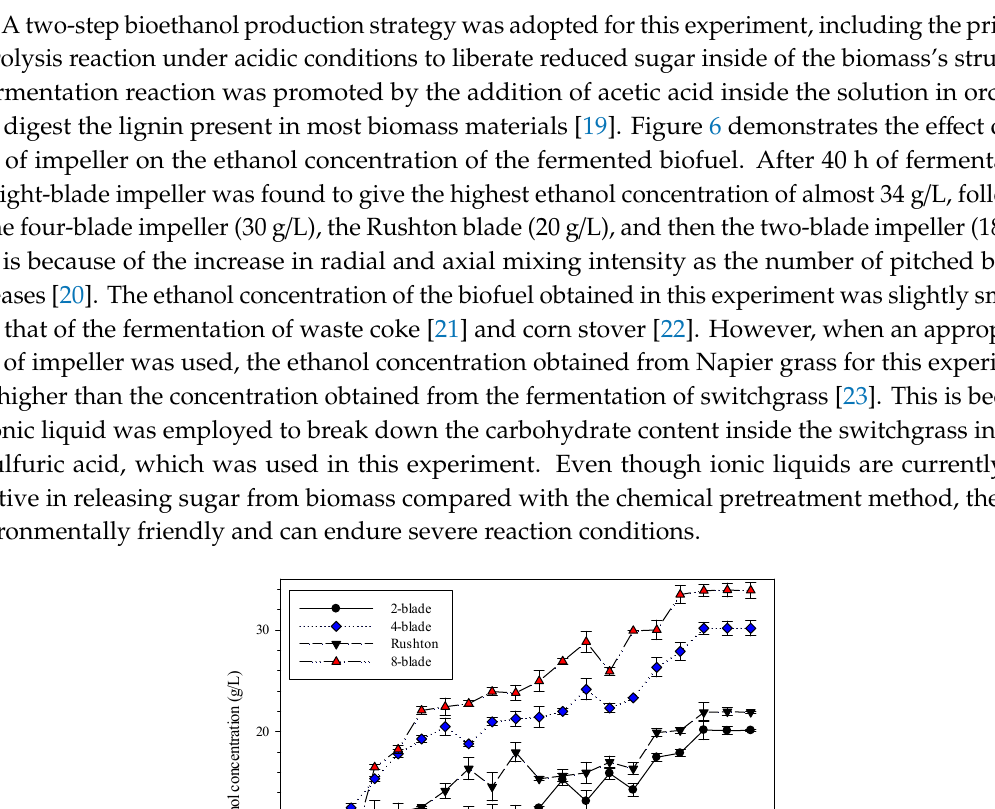
Figure 5. Simulated velocity profile of four different impellers, including a two - blade, a four - blade, a Rushton, and an eight - blade turbine .